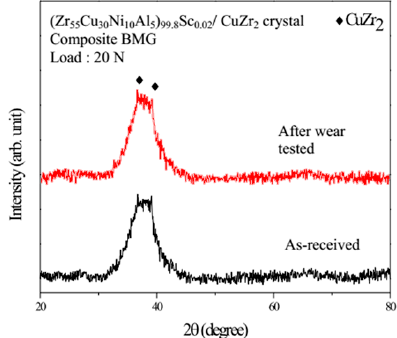
Figure 2. Comparison of X-ray di ff raction patterns of the (Zr 55 Cu 30 Ni 10 Al 5 ) 99.8 Sc 0.02 composite BMG for the as-received condition and after wear testing under a 20 N